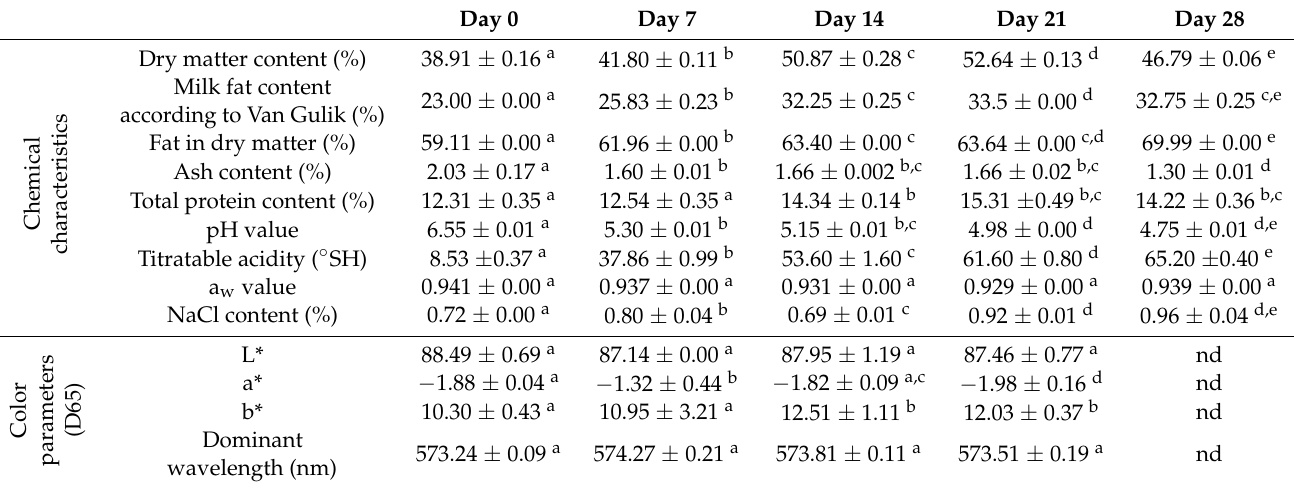
Table 2. Physico-chemical parameters of goat’s cheese during ripening.